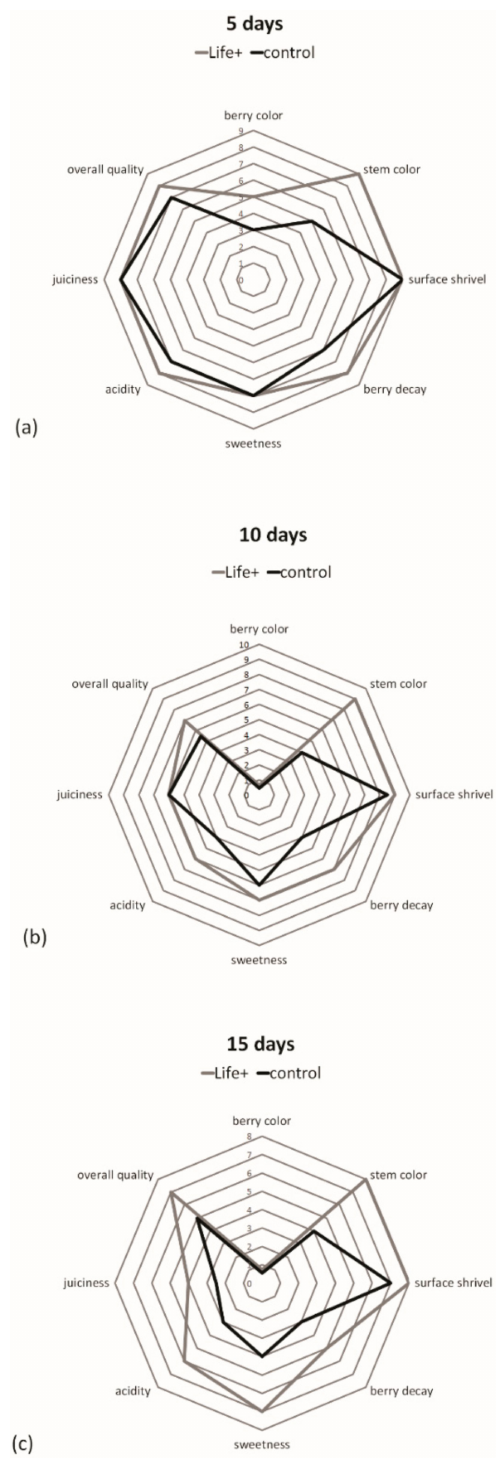
Figure 1. Sensory evaluation of sweet cherries after 5 ( a ), 10 ( b ), and 15 ( c ) days of storage at 6 ◦